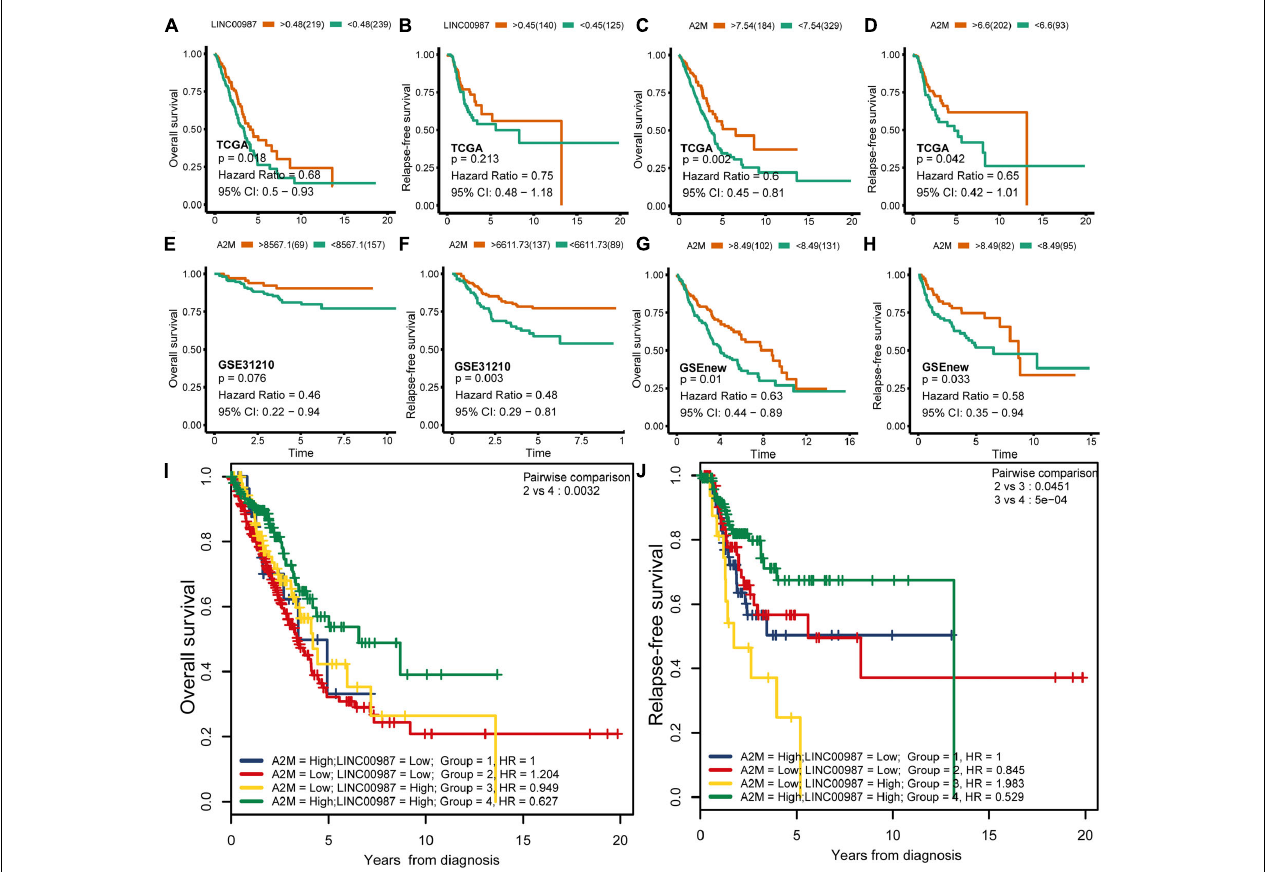
FIGURE 3 | Correlation of overall (OS) and relapse-free survival (RFS) with LINC00987 and A2M in datasets. (A–D) OS and RFS curves for LINC00987 and A2M in the TCGA cohort. (E–H) OS and RFS curves for A2M in the GSEnew and GSE31210 cohorts. (I,J) OS and RFS curves for combinations of LINC00987 and A2M in the TCGA